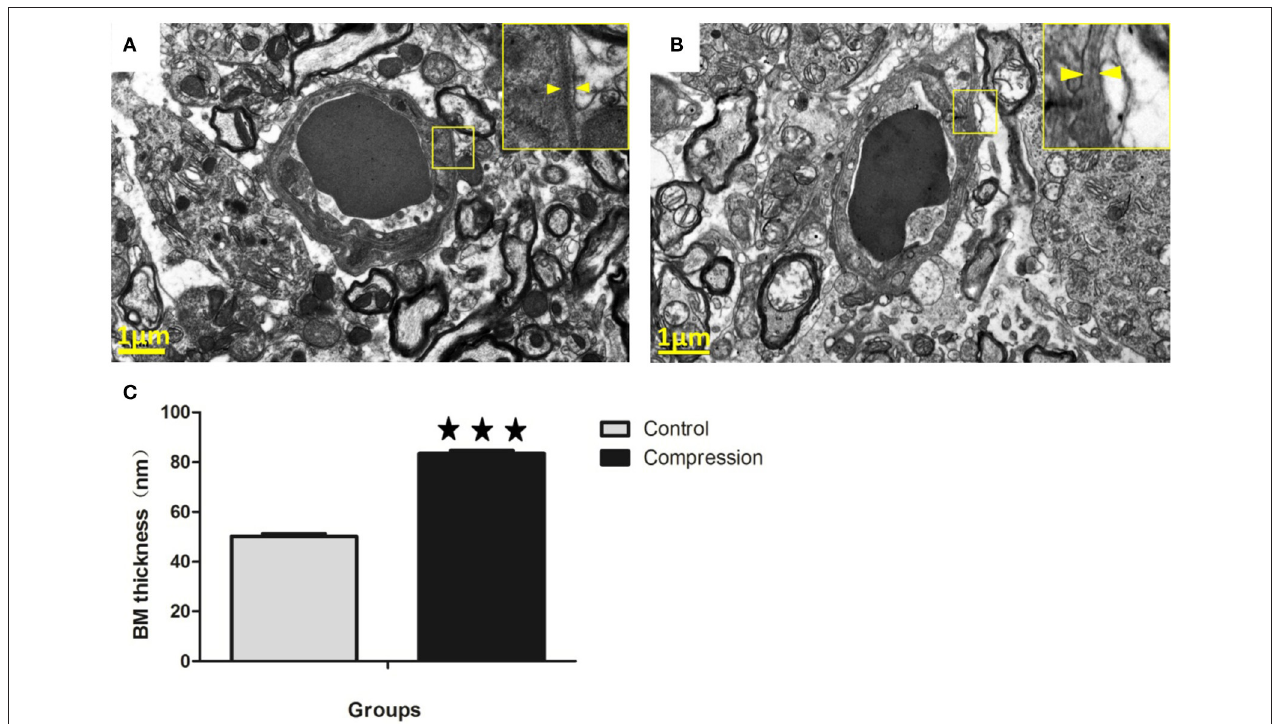
FIGURE 10 | In the control group, microvessels were encapsulated with a thin BM (A) . In the compression group, the BM was thickened considerably, but with lower electron density (B) . Histograms show that BM thickness significantly increased in the compression group (C) . The number of capillaries analyzed per group was 30, sampled from 12 rats per group. *** P < 0.001 relative to